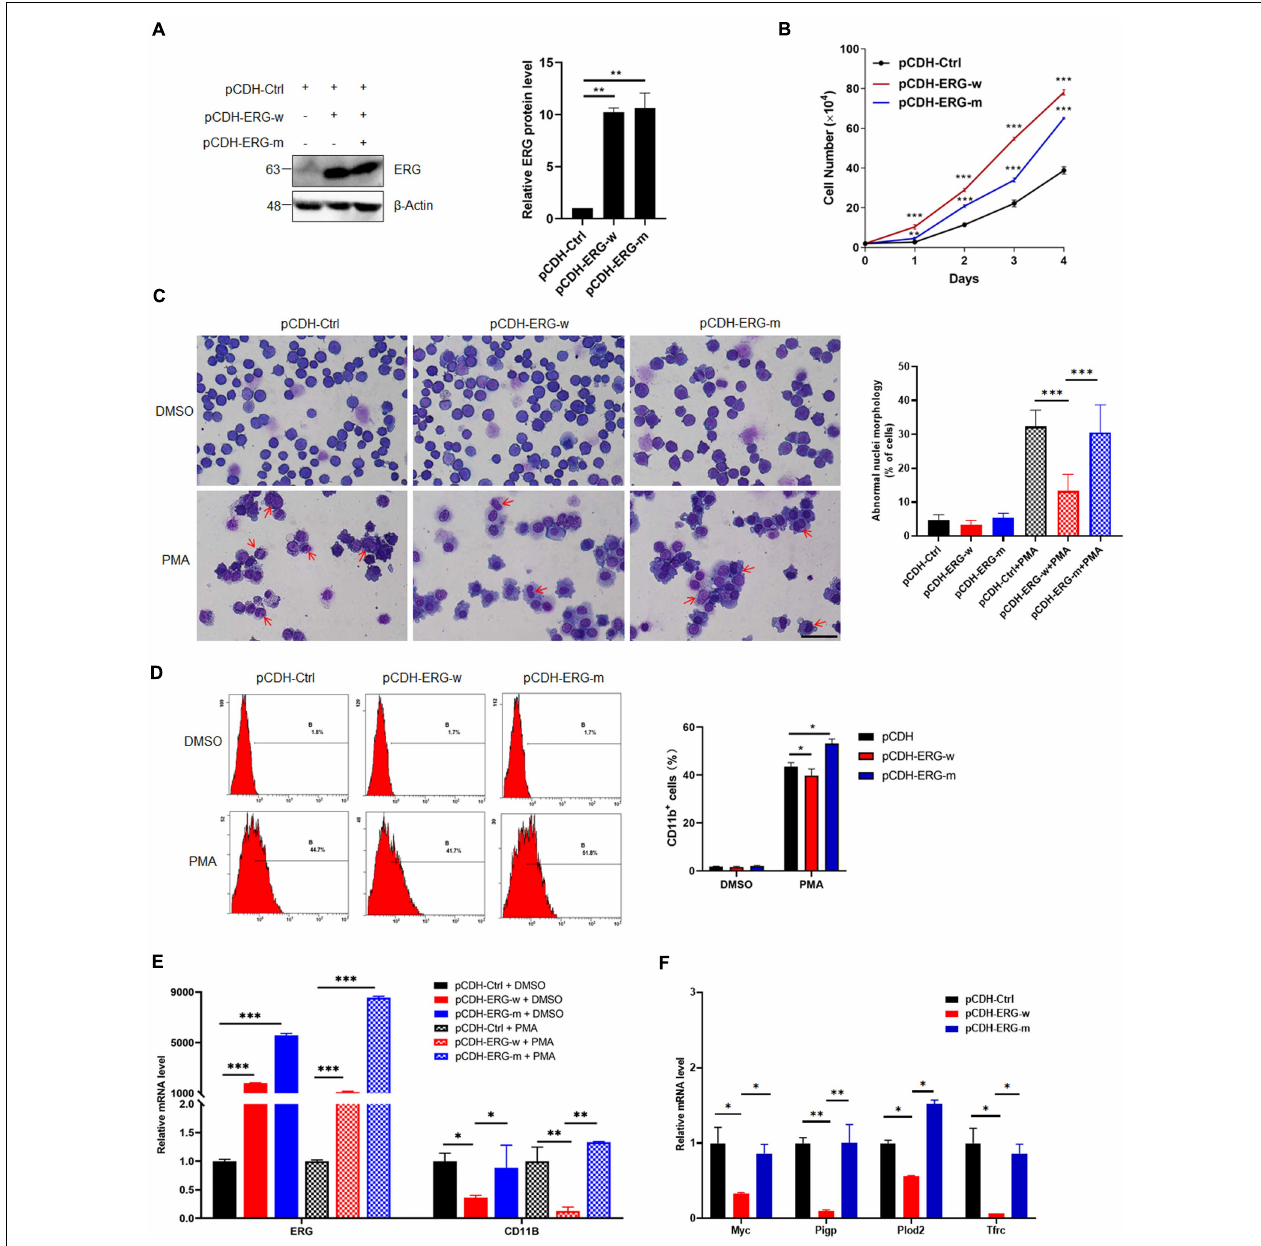
FIGURE 7 | SUMO mutant ERG reversed the increased cell proliferation and decreased cell differentiation by wild-type ERG. (A) Wild-type or SUMO mutant ERG was stably transfected into THP1 cells. The indicated lentivirus was transfected into THP1 cells, and the cell lysates of stably constructed cells were detected by IB with anti-ERG and anti- β -Actin antibodies (left). The results of quantitative analysis of Western blot are shown in the right panel ( n = 3 repeats/group, one-way ANOVA, ** p < 0.01). (B) Mutant ERG reversed the increased cell proliferation induced by wild-type ERG. Growth curves of wild-type or mutant ERG overexpression or control cells were constructed from daily quantification of cell numbers ( n = 3 repeats/group, one-way ANOVA, ** p < 0.01, *** p < 0.001). (C) Mutant ERG promoted the PMA induced morphology change of THP1 cells. Logarithmically growing THP1 cells stably transfected with wild-type or mutant ERG were exposed to DMSO or PMA for 24 h, and the cell morphology was indicated by Giemsa staining (left). The results of quantitative analysis of differentiated cells are shown in the right panel ( n = 3 repeats/group, two-way ANOVA, *** p < 0.001). The scale bar is 100 µ m. (D) Mutant ERG reversed the inhibited cell differentiation induced by wild-type ERG. Logarithmically growing THP1 cells stably transfected with wild-type or mutant ERG were exposed to PMA for 24 h. The percentage of cells expressing the monocytic maturation marker CD11b was determined by flow cytometry (Left). The percentage of cells expressing the monocytic maturation marker CD11b was quantified (right, n = 3 repeats/group, two-way ANOVA, * p < 0.05). (E) Mutant ERG rescued the mRNA level of CD11b that was decreased after wild-type ERG in THP1 cells. The expression levels of ERG and CD11b transcripts in wild-type and mutant pCDH-ERG stably transfected cells were measured by real-time PCR and normalized to pCDH-Ctrl cells ( n = 3 repeats/group, two-way ANOVA, ** p < 0.01, *** p < 0.001). (F) Mutant ERG rescued the mRNA level of ERG target genes that were decreased after wild-type ERG in THP1 cells. The expression levels of ERG and target genes transcripts in wild-type and mutant pCDH-ERG stably transfected THP1 cells were measured by real-time PCR and normalized to sh-Ctrl cells ( n = 3 repeats/group, two-way ANOVA, * p < 0.05, ** p <